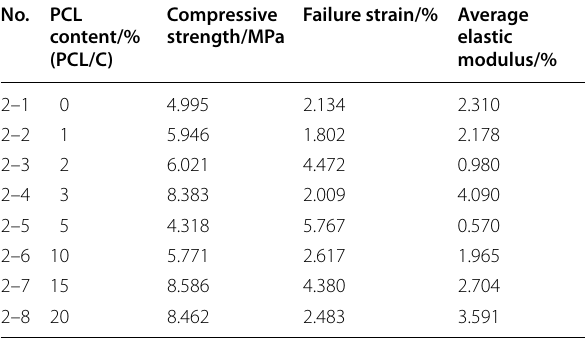
Table 7 Mechanical parameters of PCL‑cement mortar with various PCL content.